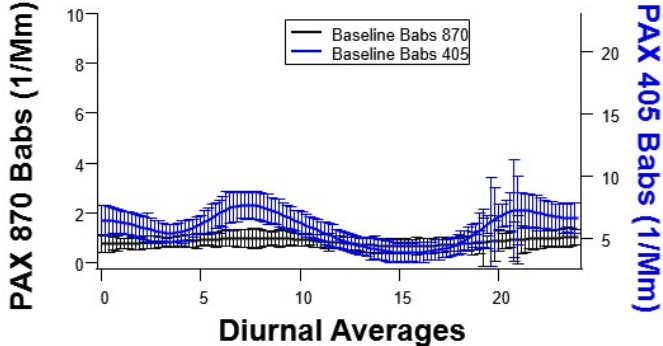
Figure 6. The baseline diurnal averages of the Babs for August and September of 2021. In black (left y -axis), the baseline as measured by PAX 870 nm with its highest peak of 1.003 1/Mm at around midnight and its lowest point of 0.6639 1/Mm at around 3:30 PM (local times). In blue (right y -axis), the baseline as measured by PAX 405 nm with its highest peak of 7.658 1/Mm at around 7:30 AM and lowest values of 3.860 1/Mm at around 3:30 PM. The graph has a smoothing filter applied (binomial smoothing by Wave Metrics Igor Pro 8 platform). The errors bars represent the standard error associated with each point.